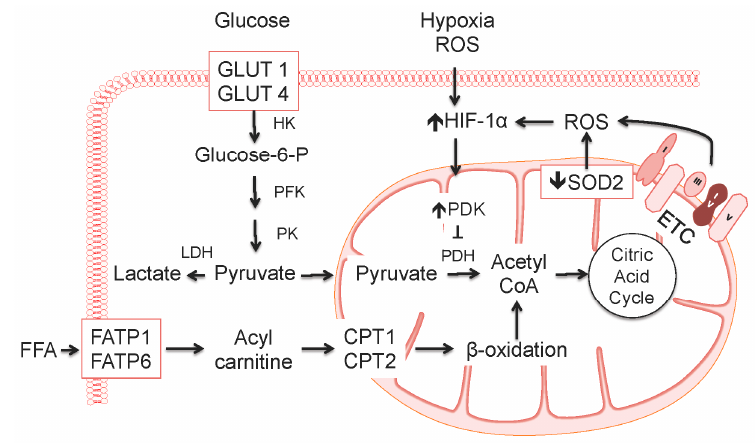
Figure 1. Metabolism in PAH. Metabolism in PAH is perturbed akin to what is observed in cancer. Glycolysis occurs when glucose is taken up by the glucose transporters-1 (GLUT-1) and -4 (GLUT-4), gets phosphorylated by hexokinase (HK), and goes through a series of reactions to produce pyruvate. Pyruvate is the substrate for pyruvate dehydrogenase (PDH) in the mitochondria to support glucose oxidation. Free fatty acids (FFA) are taken up by fatty acid transport protein-1 (FATP-1) and -6 (FATP-6) and transformed to acyl carnitines that are shuttled across the mitochondrial membrane by carnitine palmitoyltransferase-1 (CPT1) and transformed to acyl CoA by carnitine palmitoyltransferase-2 (CPT2). Acyl CoA is converted to acetyl CoA during β -oxidation. In PAH, there is increased aerobic glycolysis due to normoxic upregulation of HIF-1 α , which upregulates pyruvate dehydrogenase kinase (PDK) to inhibit pyruvate dehydrogenase, and epigenetic regulation of the superoxide dismutase 2 ( SOD2 ) gene. PFK, phosphofructokinase; PK, pyruvate kinase; LDH, lactate dehydrogenase; ROS, reactive oxygen species; ETC, electron transport